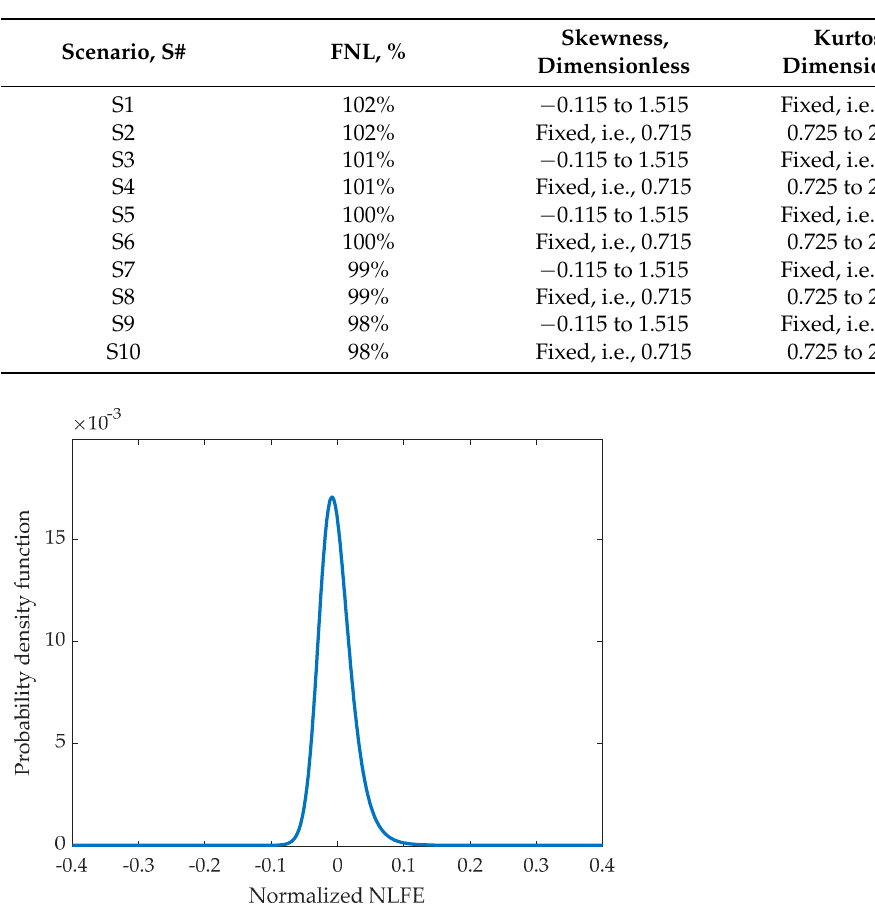
Figure 8. Probability density function of normalized NLFE: ( a ) result of changes in skewness in S5, ( b ) result of changes in kurtosis in S6.